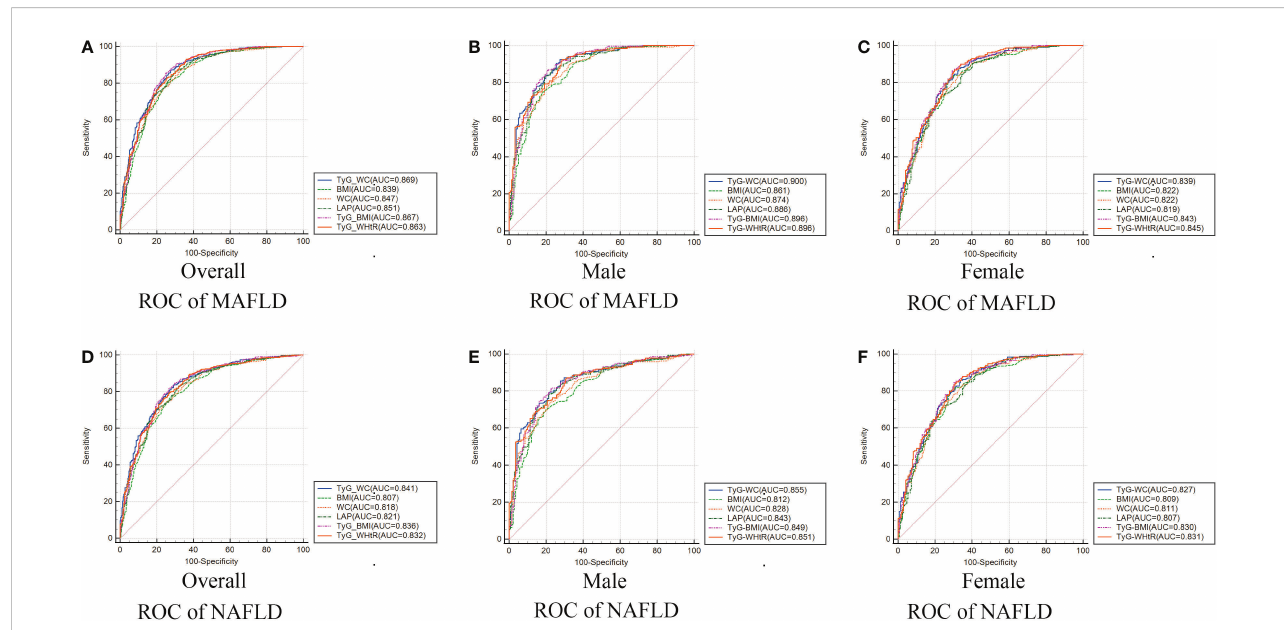
FIGURE 2 Receiver operating characteristic curves of TyG-WC and other indexes in overall (A/D), male (B/E), female (C/F) for identifying MAFLD/NAFLD. MAFLD, metabolic dysfunction-associated fatty liver disease; NAFLD, non-alcoholic fatty liver disease; TyG, triglyceride and glucose index; WC, waist circumference; BMI, body mass index; LAP, lipid accumulation product; WHtR, waist-to-height ratio.